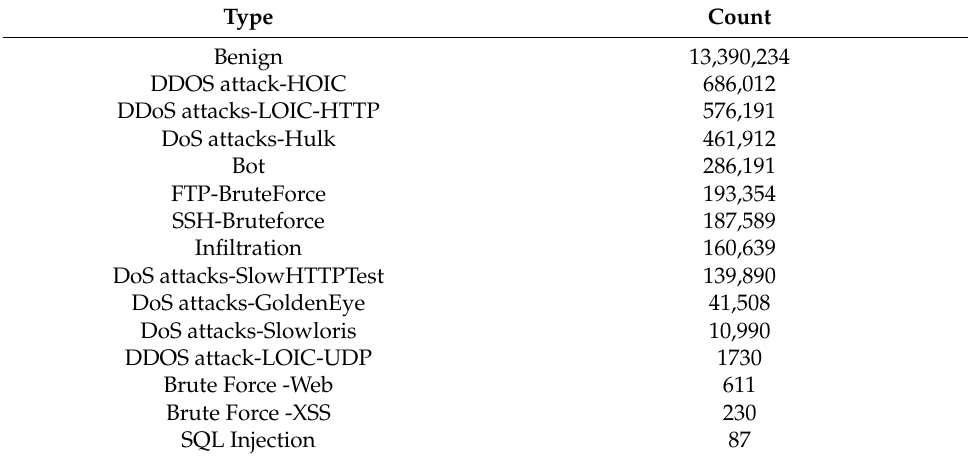
Table 1. Types of flows in dataset with number of